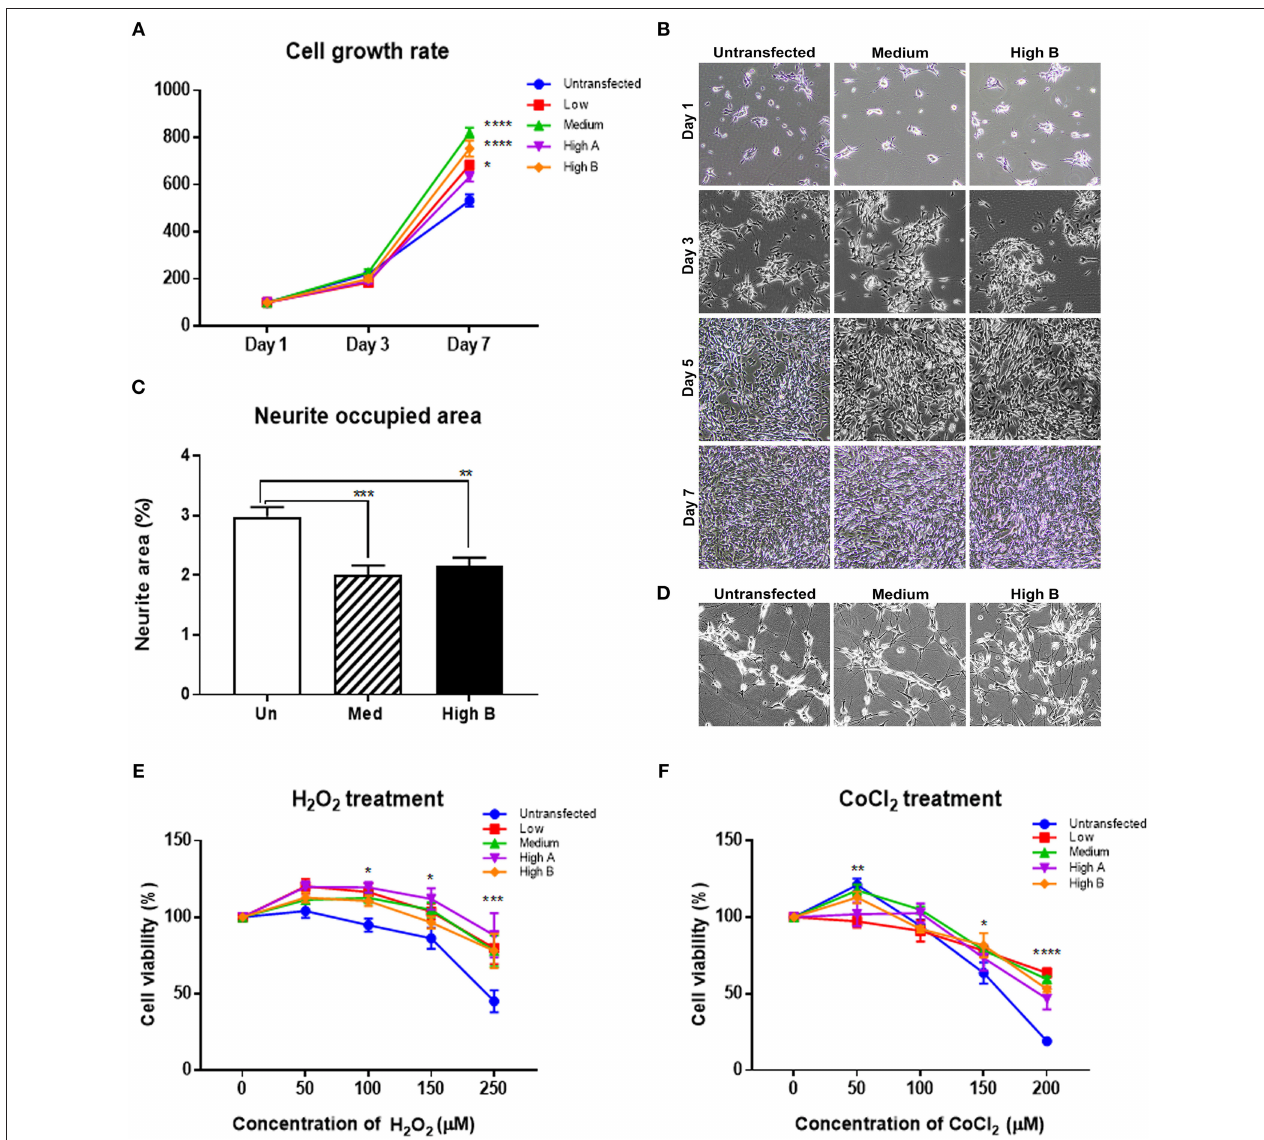
FIGURE 6 | Phenotyping of FtMt expressing neuronal cells. (A,B) Measurements of Cell Growth Rates of Undifferentiated FtMt clones. (A) Results showing relative increase in cell area occupied as percentage of Day 1 of FtMt clones and untransfected cells. Results show analyses at Day 7. Measurements involved area occupied of growing cells identified using Image J image analysis software. Data analyzed by Two-way ANOVA. Relative statistical differences between clones and are listed in Table 2A . (B) Representative photomicrographs of proliferating clones untransfected, Medium FtMt expressor and High B FtMt expressor at Day 1, Day 3, Day 5, and Day 7. (C,D) Measurements of Neurite formation of Differentiated FtMt clones. (C) Results showing relative area occupied of neuritic processes at day 7 of untransfected (Un), Medium FtMt expressor (Med) and High Ft expressor (High B). Measurements involved measuring area occupied of neurites identified using NeuronJ plugin of Image J image analysis software. Results are representative of triplicate experiments. Relative statistical differences between clones listed in Table 2B . (D) Representative photomicrographs of differentiated, untransfected, Medium FtMt expressor and High B FtMt expressor at Day 7. (E,F) Responses of FtMt overexpressing clones to oxidative stress. (E) Changes in cell viability (as percentage of untreated cultures) with increasing doses of hydrogen peroxide (H 2 O 2 ) (0–250 µ M). Untransfected and FtMt expressing clones were differentiated in microtiter plate wells for 7 days. Treatments added to media lacking RA containing 1% FBS on day 7 for 24h. Cell viability assessed by added WST-1 reagent after 24h. Absorbance (450nm) measured after 1, 2, and 4h. Results presented (mean ± SEM) of six wells/treatment and combination of three independent experiments. Data analyzed by Two Way ANOVA. Relative statistical differences between clones and treatments are listed in Table 3A . (F) Changes in cell viability (as percentage of untreated cultures) with increasing doses of Cobalt Chloride (CoCl 2 ) (0–200 µ M). Untransfected and FtMt expressing clones were differentiated in microtiter plate wells for 7 days. Treatments added to media lacking RA containing 1% FBS on day 7 for 24h. Cell viability assessed by added WST-1 reagent after 24h. Absorbance (450nm) measured after 1, 2, and 4h. Results presented (mean ± SEM) of six wells/treatment and combination of three independent experiments. Data analyzed by Two-way ANOVA. Results indicate level of significance. * p < 0.05; ** p < 0.01, *** p < 0.001, **** p < 0.0001. Relative statistical differences between clones and treatments are listed in Table 3B .